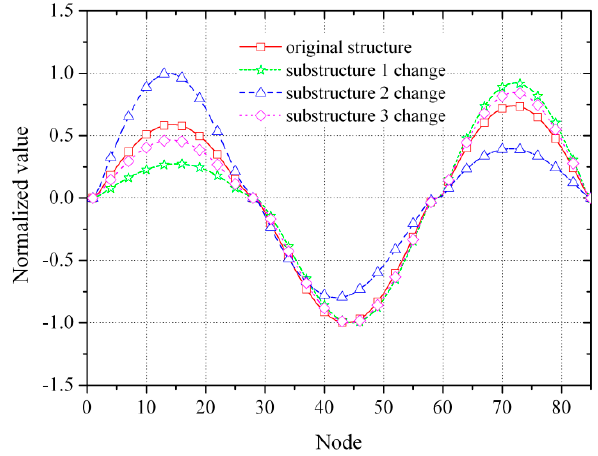
Figure 12. The first mode shape of the main bridge with cross-section stiffness change.